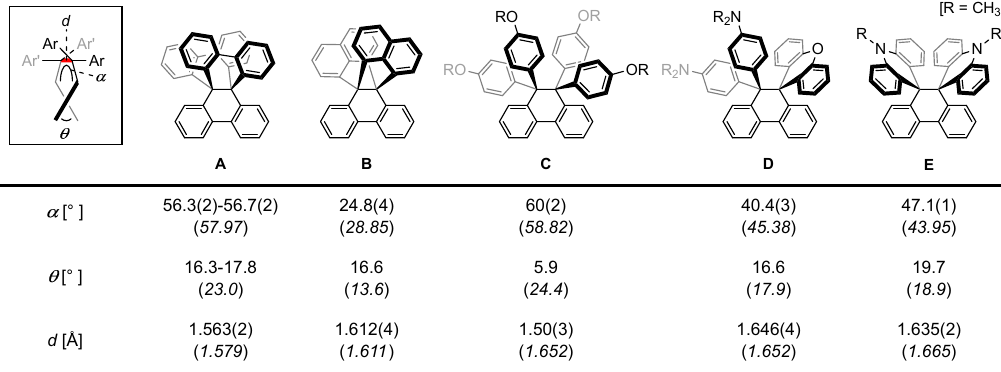
Figure 1. Reported structural parameters of Ar 4 DHPs determined by X-ray analyses. The values obtained by DFT calculations at the B3LYP/6-31G* level in this study are shown in brackets.